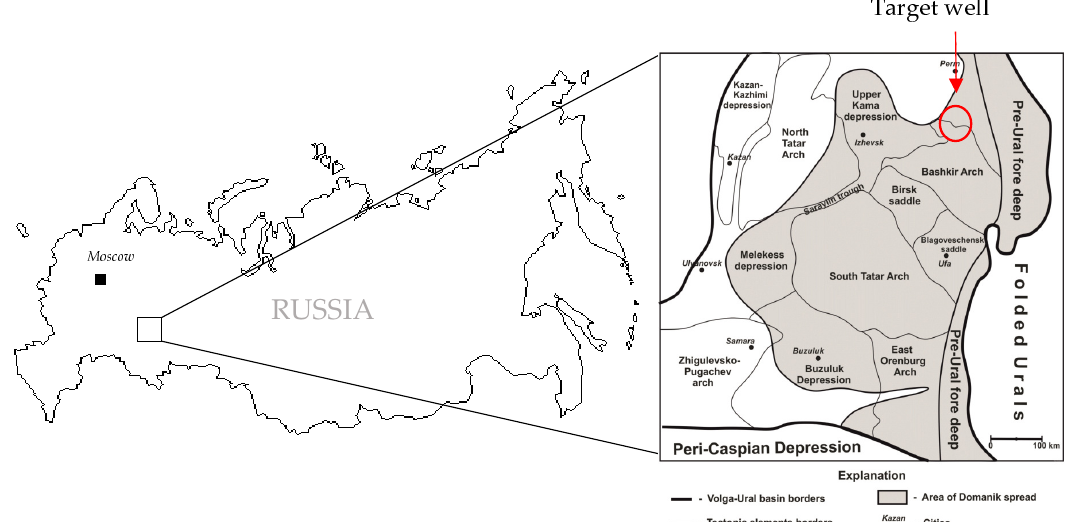
Figure 1. The geographic location of the target formation (modified after [35]).